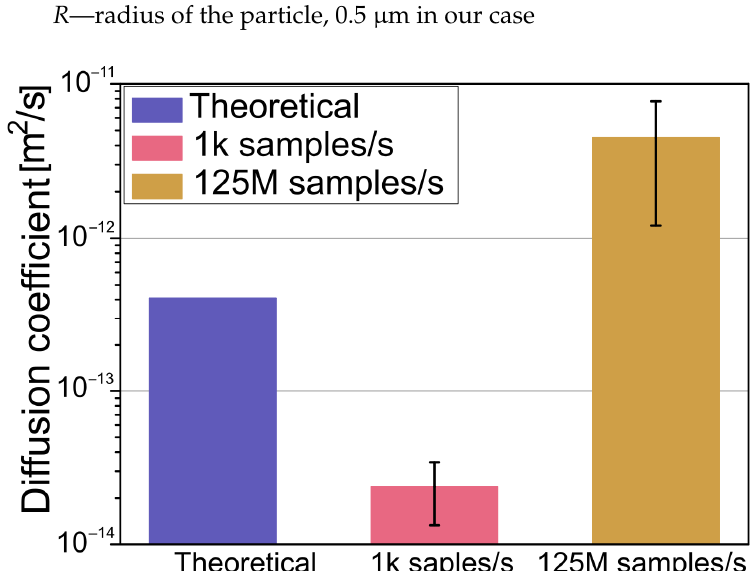
Figure 5 . Measured diffusion of 1 μ m polystyrene particle in an optical tweezers system with a 1 Figure 5. Measured diffusion of 1 µ m polystyrene particle in an optical tweezers system with a pN/nm trap stiffness, along with theoretical calculations for a freely moving particle. 1 pN/nm trap stiffness, along with theoretical calculations for a freely moving